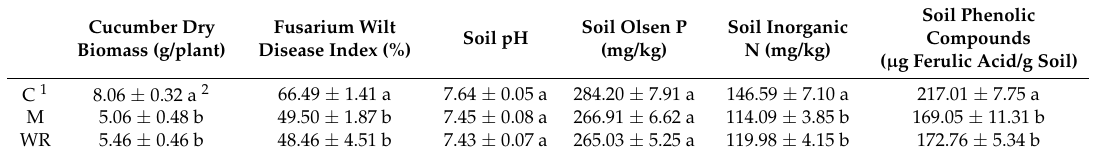
Table 1. Effects of crop rotations on cucumber seedling dry biomass, Fusarium wilt disease index, and soil chemical